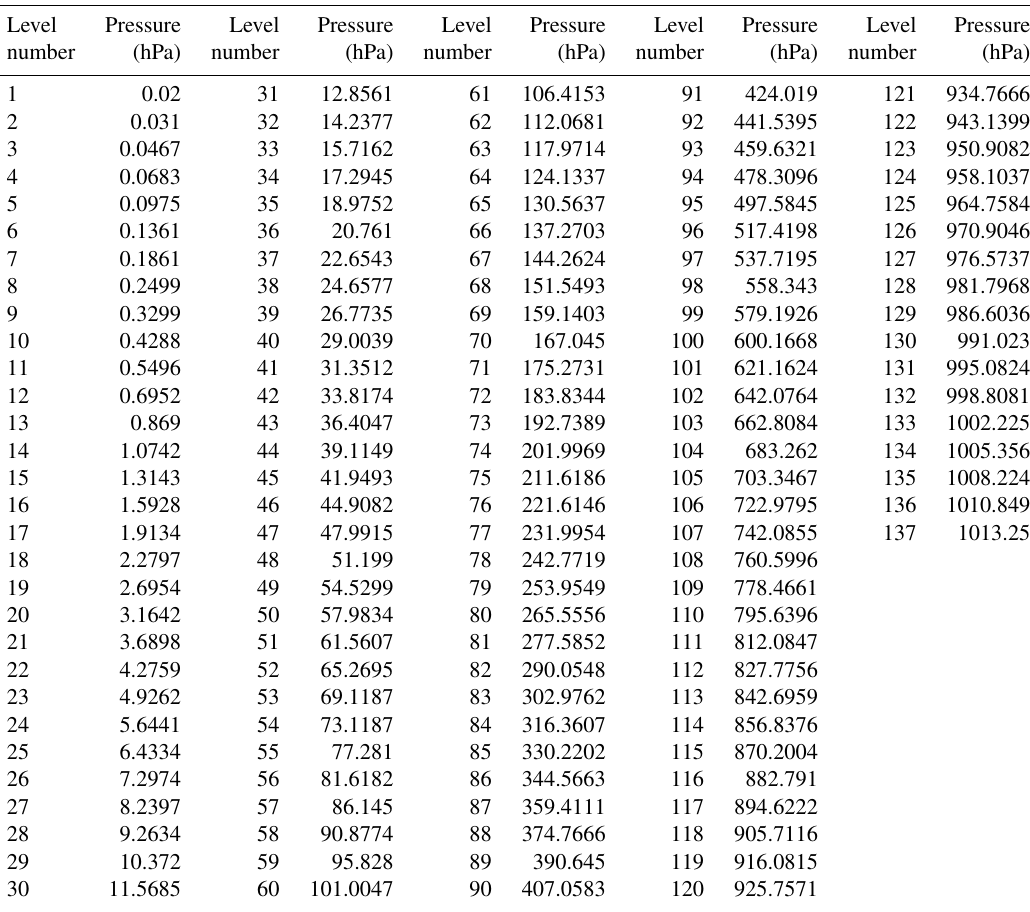
Table A2. Pressure levels adopted for IFS-137: 137 pressure levels (in